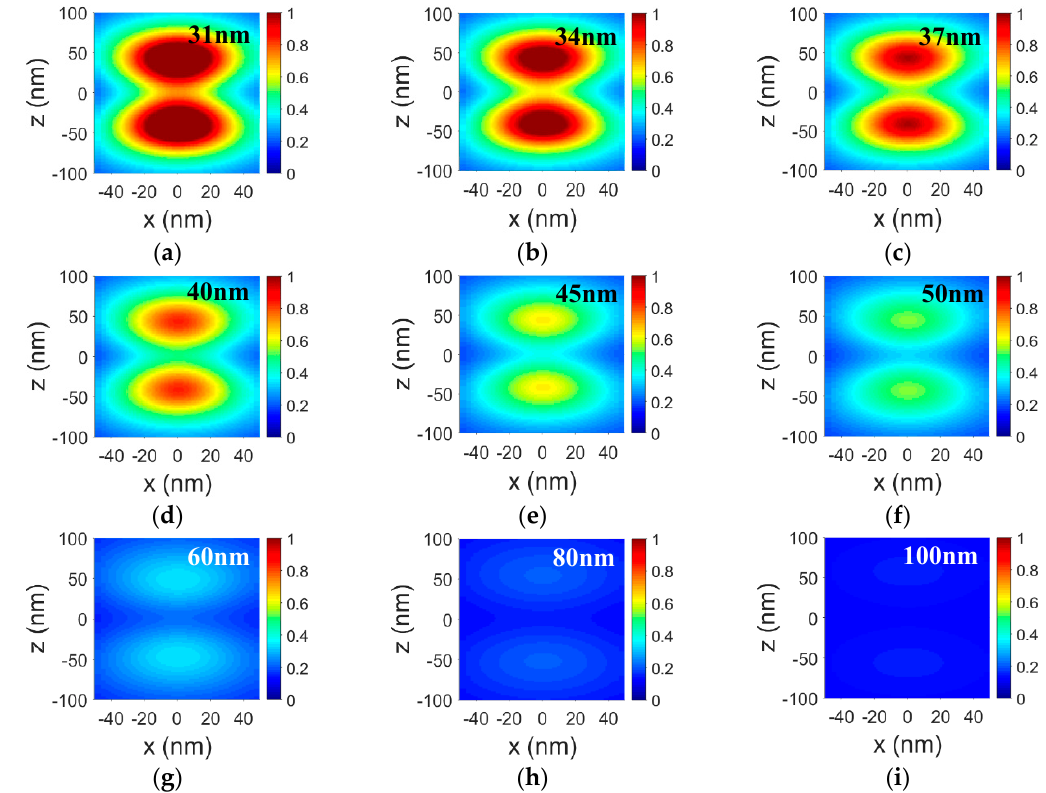
Figure 5. The electric field distributions of the single silver nanorod with a diameter of 30 nm and a length of 100 nm for the TE polarization of the incident light (along the z-direction). ( a – i ) The electric field profiles of E(x, z) at 517 nm in different near field regions when adding the 2D y-normal monitor in the positions of y = 31, 34, 37, 40, 45, 50, 60, 80, and 100 nm, respectively.